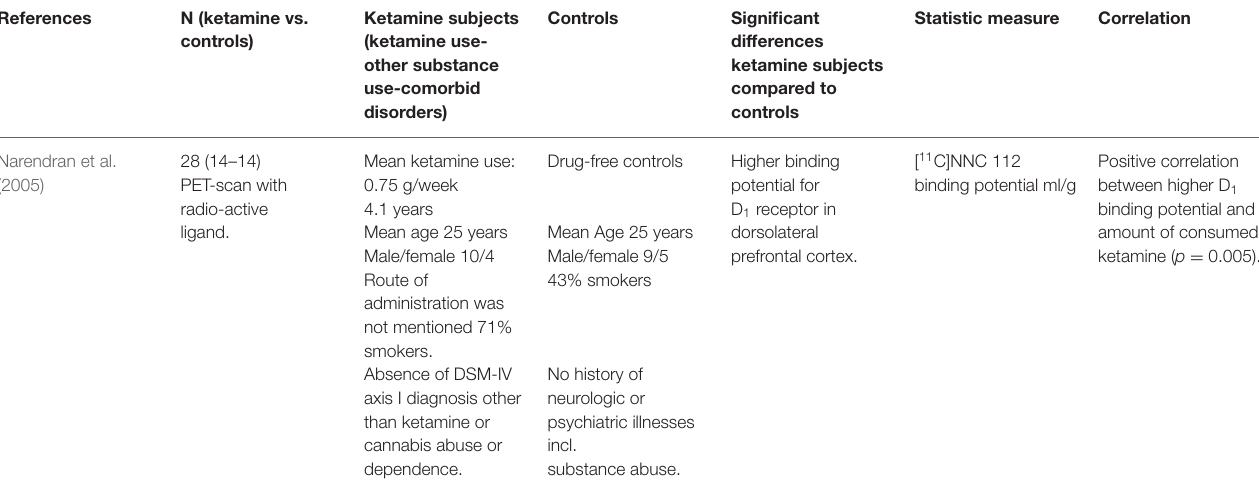
TABLE 4 | D 1 receptor.